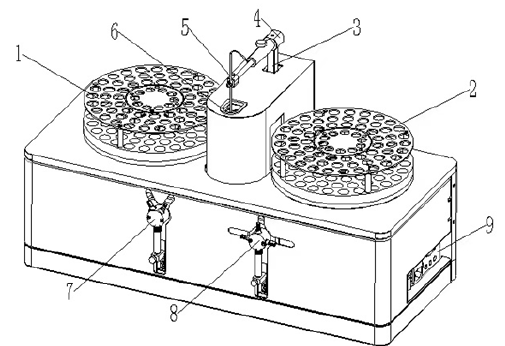
Molecules 2022 , 27 , x FOR PEER REVIEW Figure 4. The automated diluted acid extraction system: (1) left sample tray with oscillation part; (2) right sample tray with oscillation part; (3,4) rotary lifting injection mechanical arm; (5) injection needle; (6) washing basin; (7) 5 mL syringe pump; (8) 100 µ L syringe pump; (9) interface assembly board.